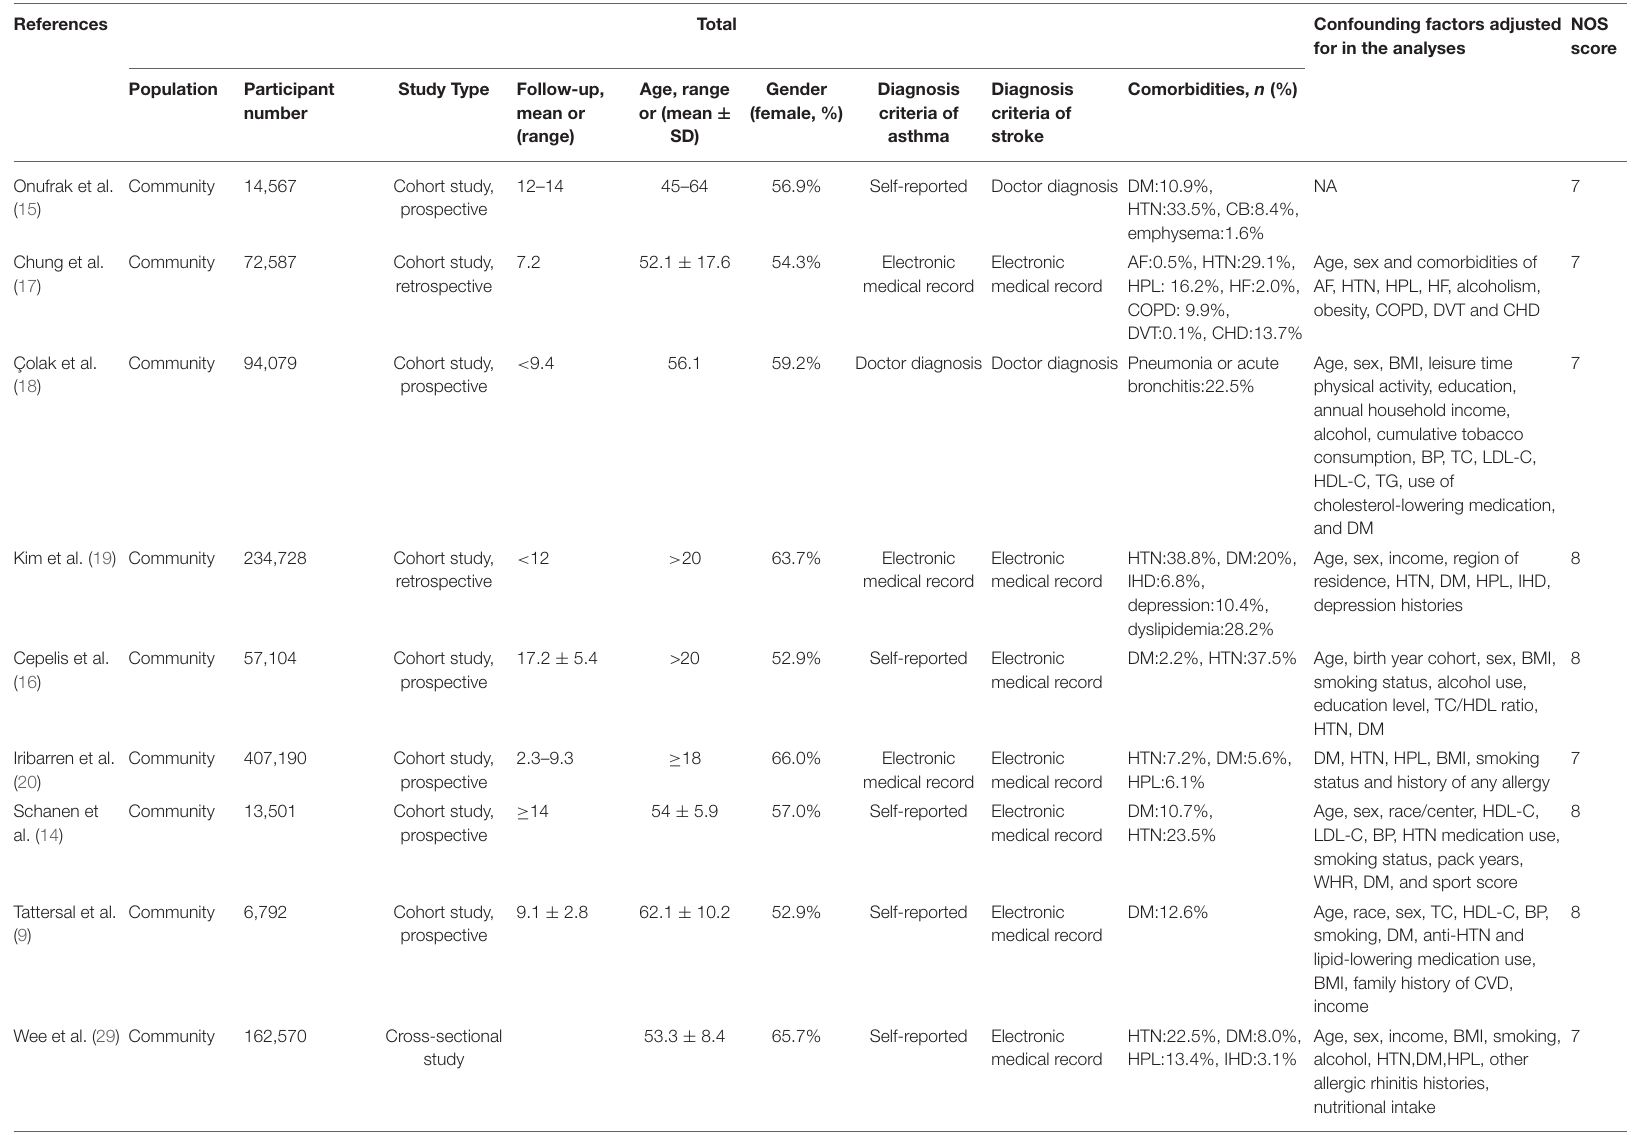
TABLE 1 | Baseline characteristics of participants assessed in the studies included in the